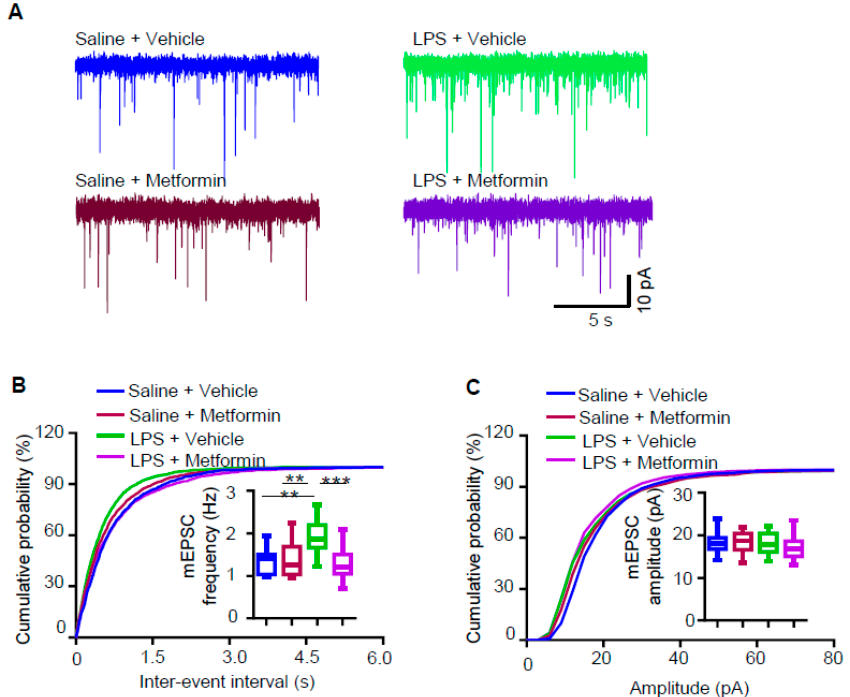
Figure 4. Metformin reduces increased mEPSC frequency in LPS-induced depression mouse model. ( A ) Representative traces of mEPSCs in CA1 pyramidal neurons from mice of four different groups: saline + vehicle (blue), saline + metformin (brown), LPS + vehicle (green) and LPS + metformin (purple). ( B , C ) Cumulative probability plots of mEPSC interevent intervals and histograms of mEPSC frequency ( B ) and amplitude ( C ) (n = 14–16 neurons from 3 mice for each group; one-way ANOVA, ** p < 0.005, *** p < 0.001).